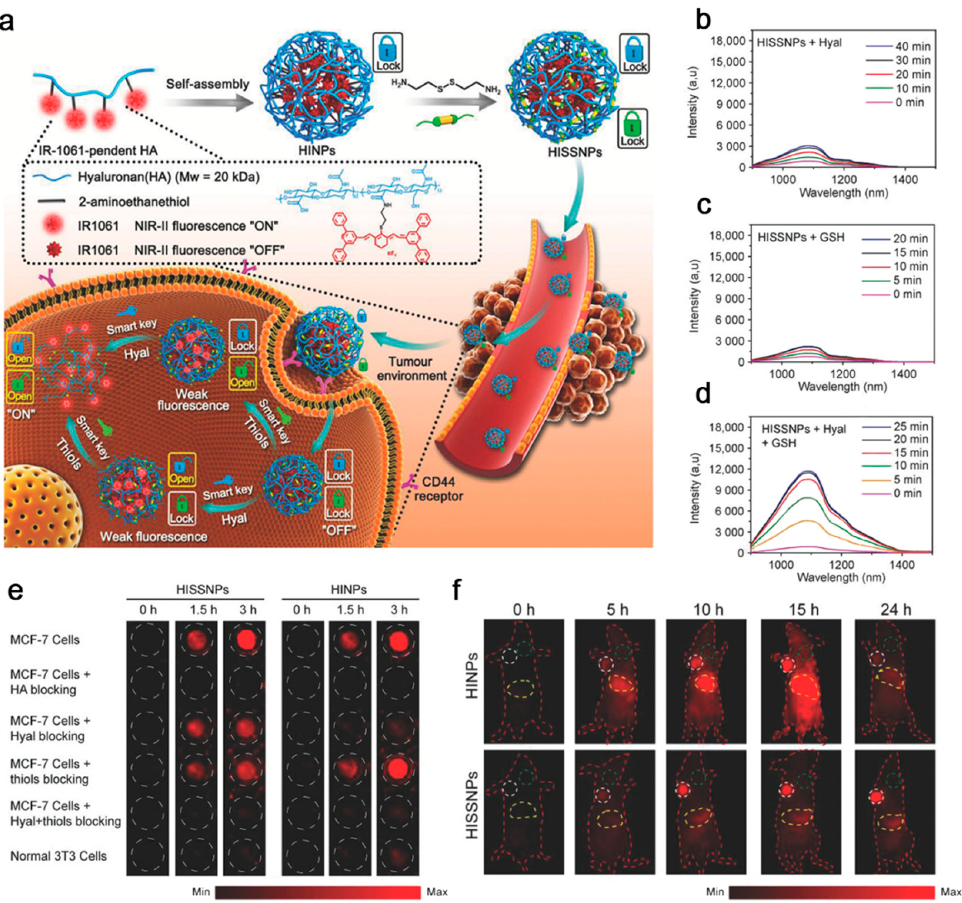
Figure 10. ( a ) Schematic diagram of the synthetic route of dual-lock-and-key-controlled NIR-II fluorescence probe HISSNPs and its corresponding mechanism for tumor-specific imaging. Time-dependent fluorescence (excited at 808 nm) spectra of HISSNPs incubated with ( b ) Hyal, ( c ) GSH, and ( d ) Hyal and GSH in PBS. ( e ) NIR-II fluorescence imaging of 3T3 cells and MCF-7 breast cancer cells at the time points of 0 h, 1.5 h, and 3 h after different treatments. ( f ) Time-dependent NIR-II fluorescence imaging of MCF-7 cancer xenografts model mice after injection with HISSNPs and HINPs (35 mg/kg). White circle: tumor site; yellow circle: abdominal liver site; green circle: muscle (refers to normal tissue). Reproduced with permission [139]. Copyright 2018, WILEY-VCH.